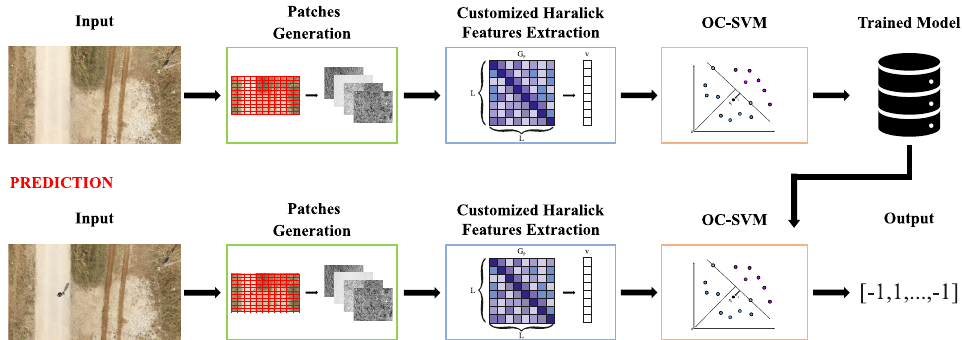
Figure 1. Overview of the proposed architecture. Starting from an RGB image of a video sequence, patches are generated on the grayscale transformed input. Subsequently, customized Haralick textural features based on a discretized circumference are generated and used to train an OC-SVM classifier. Finally, at inference time, the hyperplane found by the OC-SVM is used to detect anomalies in the patches extracted from the analyzed